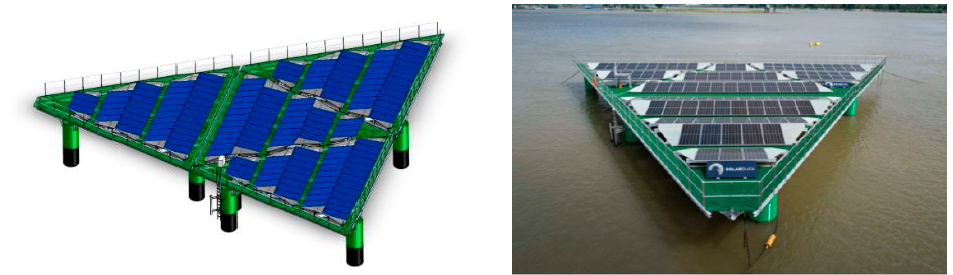
Figure 7. Triangular floating platform structure [35]. [Permission of using the figure has been requested from the copyright holder Solarduck].